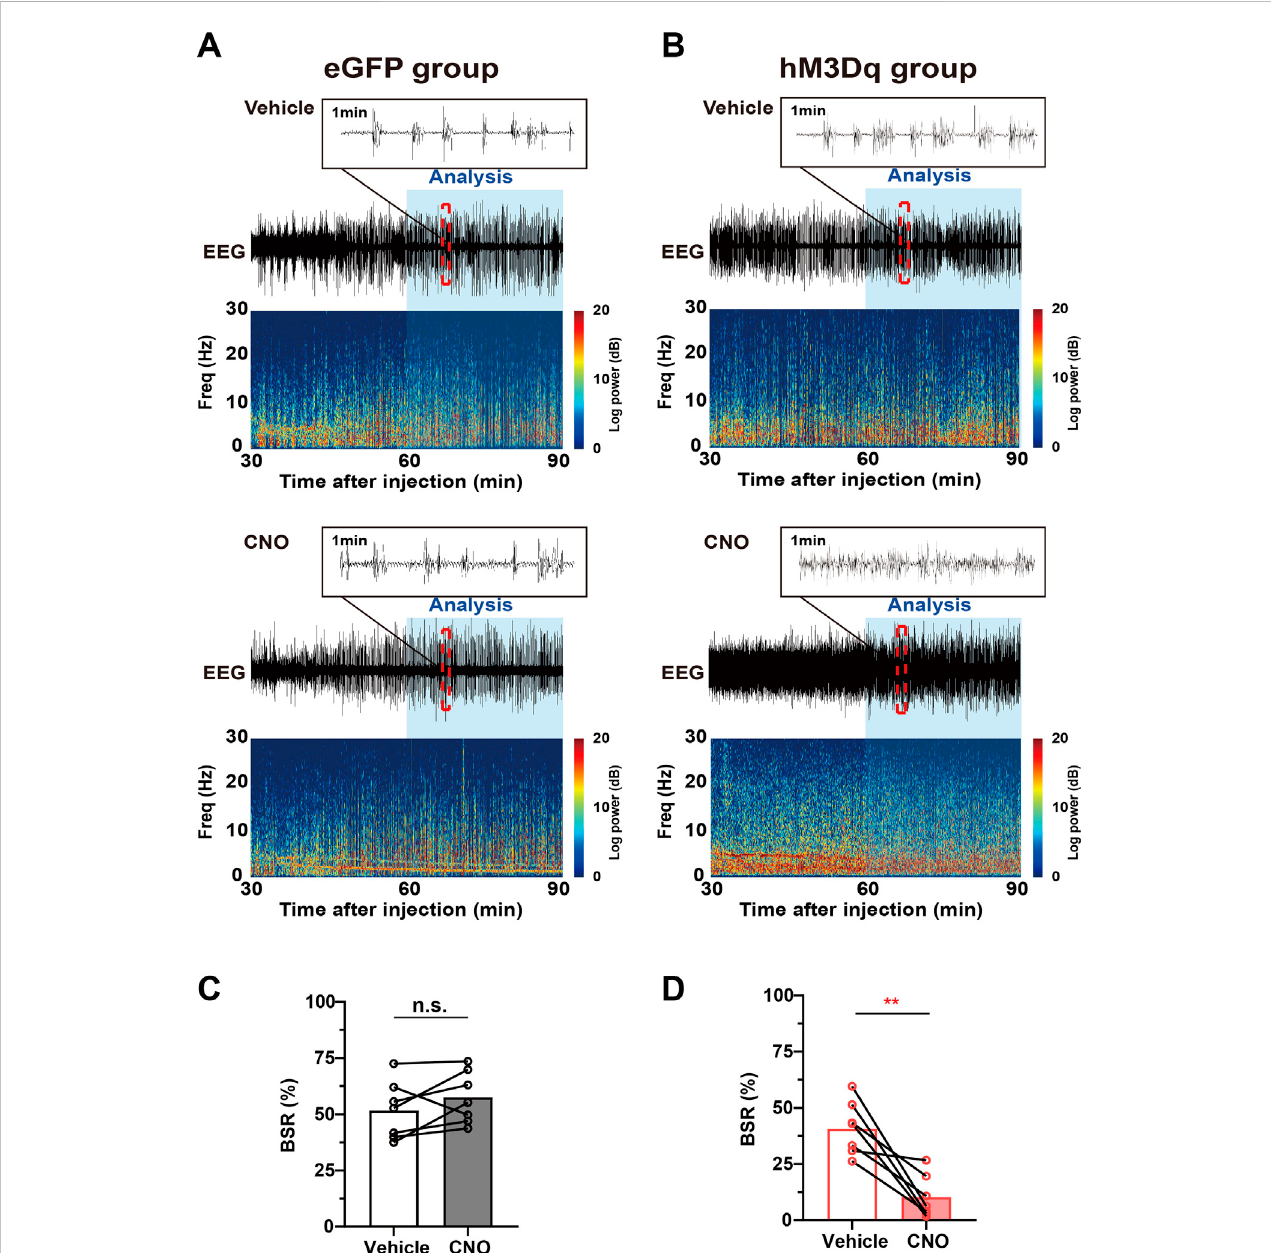
FIGURE 5 Chemogenetic activation of PBN astrocytes decreases the BSR under 1.0% iso fl urane anesthesia. (A) Schematic diagram of representative burst- suppression oscillation of the eGFP group after vehicle (top) or CNO (3 mg/kg, bottom) injection under 1.0% iso fl urane anesthesia. (B) Schematic diagram of representative burst-suppression oscillation of the hM3Dq group after vehicle (top) or CNO (3 mg/kg, bottom) injection under 1.0% iso fl urane anesthesia. (C) Statisticsshowing the change in the BSR after vehicle and 3 mg/kg CNO injection in the eGFP group during 1.0% iso fl urane anesthesia. Paired t -test ( n = 7). (D) Statistics showing the change in the BSR after vehicle and 3 mg/kg CNO injection in the hM3Dq group during 1.0% iso fl urane anesthesia. Paired t -test ( n = 7). Values represent mean ± SEM; * p < .05 or ** p < .01 shows signi fi cant differences between the vehicle and experimental groups. BSR, burst-